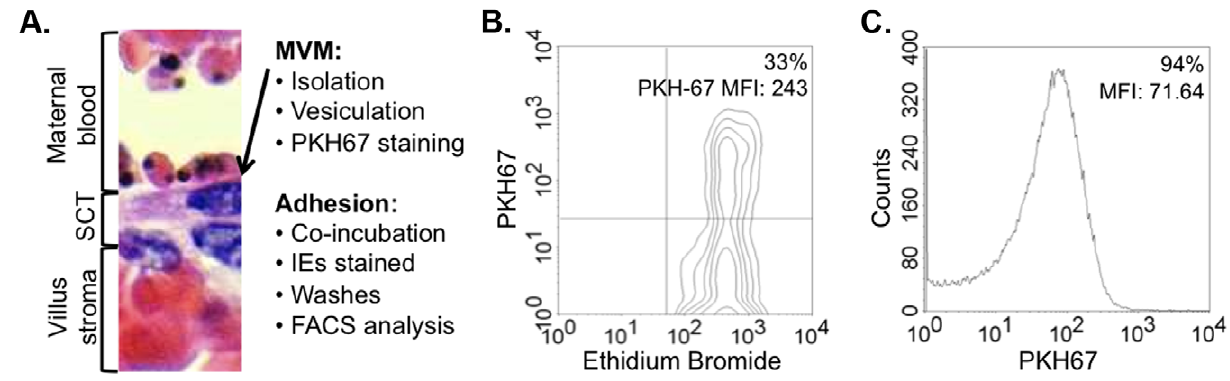
Figure 1. Assay principle. ( a. ) The epithelial microvillous plasma membrane (MVM) is purified from the host epithelium (the syncytiotrophoblast, or SCT, layer of the human placenta in this case) and forced to vesiculate. Vesicles labeled with the fluorescent lipid dye PKH-67 are co-incubated with pathogens (ethidium bromide-stained P. falciparum -infected erythrocytes (IE) of the placental-type line CS2 in this example). Unbound vesicles are washed off prior to acquisition on a flow cytometer. ( b. ) A typical cytogram shows that 33% of IE (ethidium bromide + erythrocytes) have bound vesicles detected by their PKH67 fluorescence. The adhesion intensity is measured by the mean PKH67 fluorescence intensity (MFI) of pathogens bound to vesicles (243 in the example given). ( c. ) The PKH67 MFI of pathogens bound to vesicles is used to calculate the average number of vesicles bound per pathogen by dividing it by the PKH67 MFI of the vesicles used derived from the histogram shown. In the example given, each IE that adhered to vesicle was bound to an average of 243/71.64=3.4 vesicles.